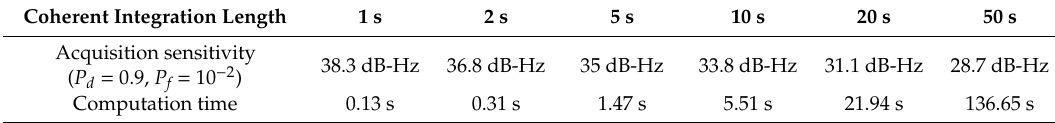
Table 3. The acquisition sensitivity and computation time of the VLDA methods.